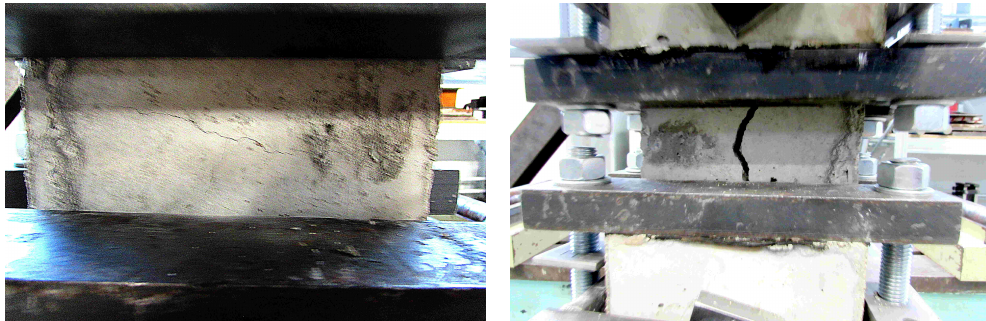
Figure 8. Transverse (left) and longitudinal (right) crack during cyclic